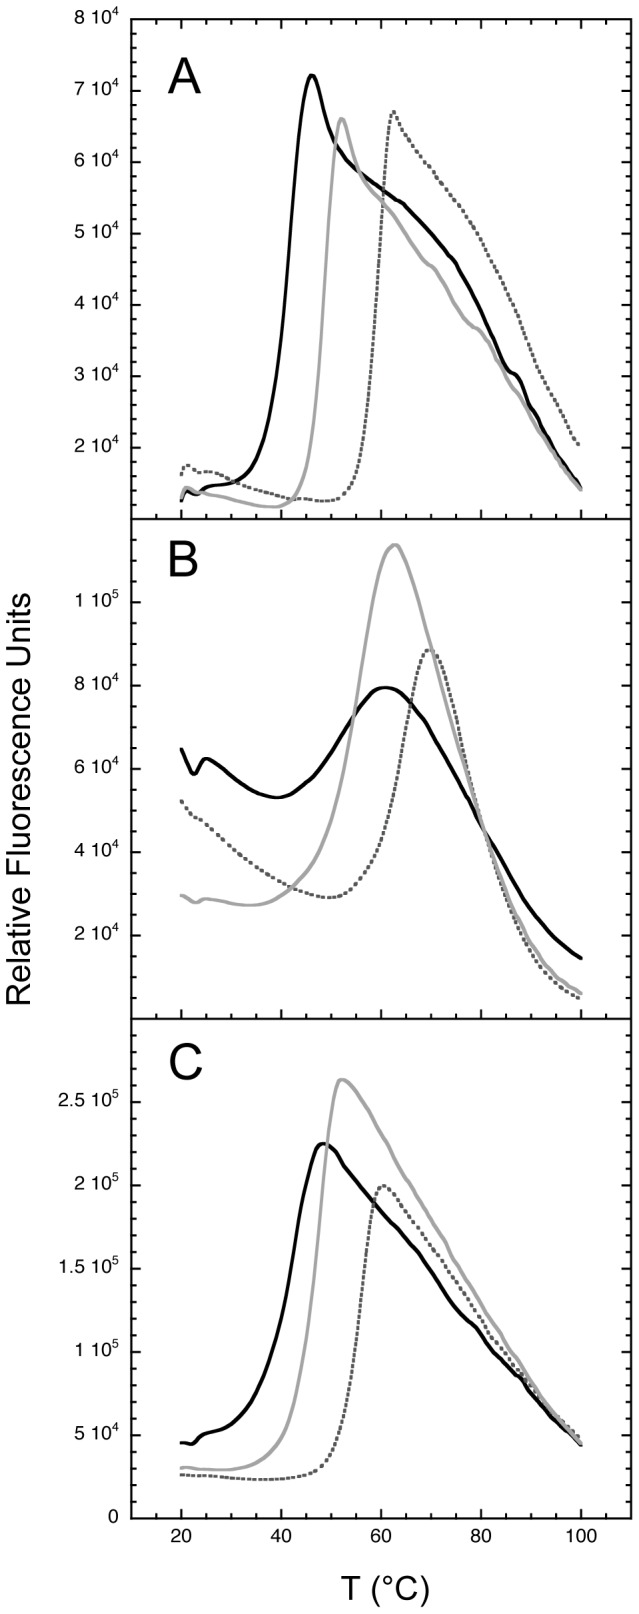
Thermal denaturation of EngA, GD1 and GD2-KH and protective effects of nucleotides.The denaturation of EngA (A), GD1 (B) and GD2-KH (C) was monitored by the Thermal Shift Assay in the absence (plain black lines) or in the presence of 1 mM GMPPNP (plain grey lines) or 1 mM GDP (dotted grey lines).